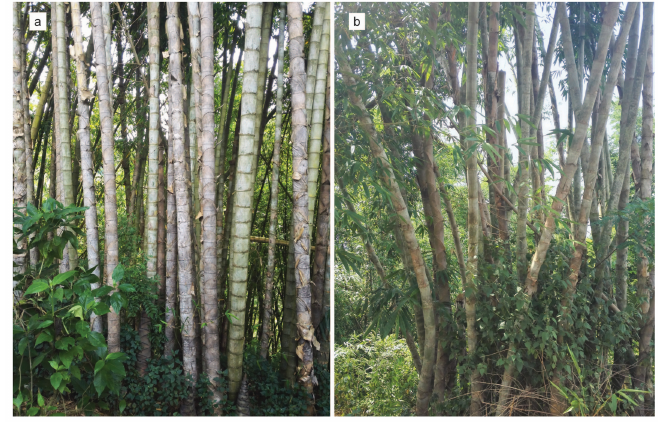
Figure 1. Vegetative forms of straight-culm ( a ) and bent-culm ( b ) Dendrocalamus sinicus